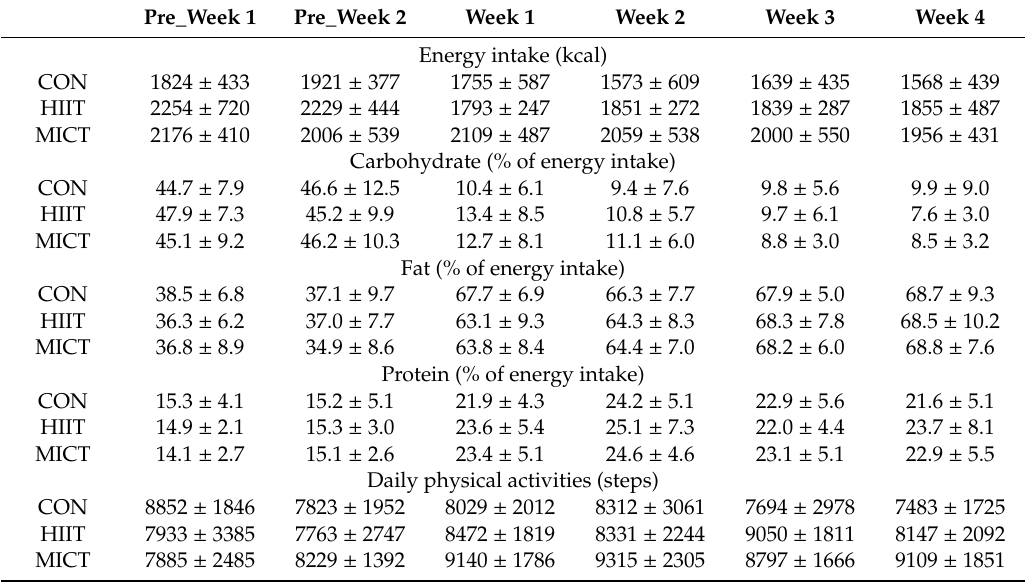
Table 2. Energy intake, nutrient proportions, and physical activity before and during intervention.